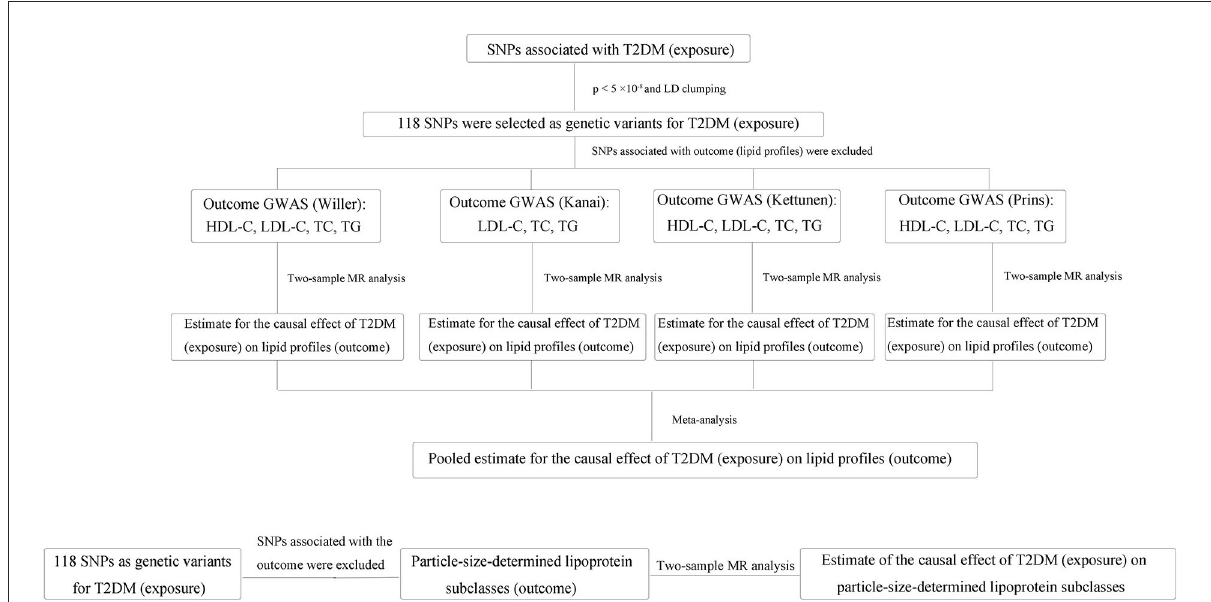
FIGURE1 Flow diagram of the overview of our study design. First, we conducted a two-sample MR study to investigate the potential causal effects of genetically predicted T2DM on genetically predicted blood lipid profiles according to different large GWAS data resources, respectively. Then, we performed the overall meta-analysis to obtain the summary results by meta-analyzing each MR result to determine those causal effects more comprehensively across different data sources. In addition, the estimates of the causal effect of T2DM on each particle-size-determined lipoprotein subclass were also made via the two-sample MR method. SNP, single-nucleotide polymorphism; T2DM, type 2 diabetes mellitus; GWAS, genome-wide association study; HDL, high-density lipoprotein; LDL, low-density lipoprotein; TC, total cholesterol; TG, triglycerides; MR, Mendelian